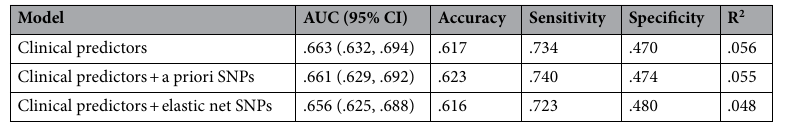
Table 4. Model performance for baseline features when people that experienced distressing and intolerable side effects were removed from the treatment outcome. Clinical predictors model includes sociodemographic and pre-treatment symptom variables only. The model in the second row adds SNPs selected a priori based on work by 10 to the clinical predictors model.The model in the third row adds the SNPs identified by the elastic net feature selection to clinical predictors model. For threshold-dependent metrics (accuracy, sensitivity, specificity), a probability threshold of 0.5 was used for